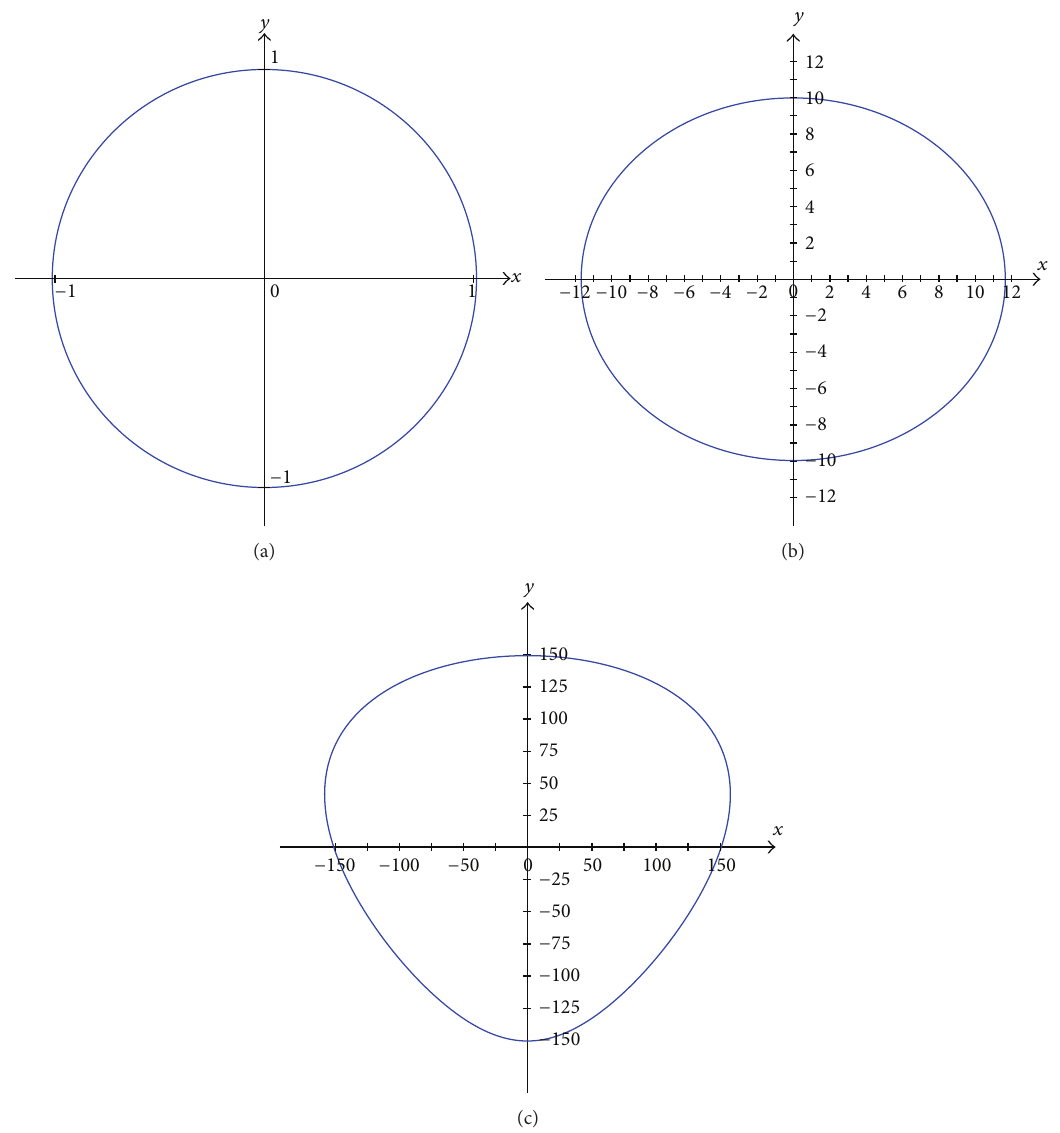
Figure 1: Orbits of the moon, schematically